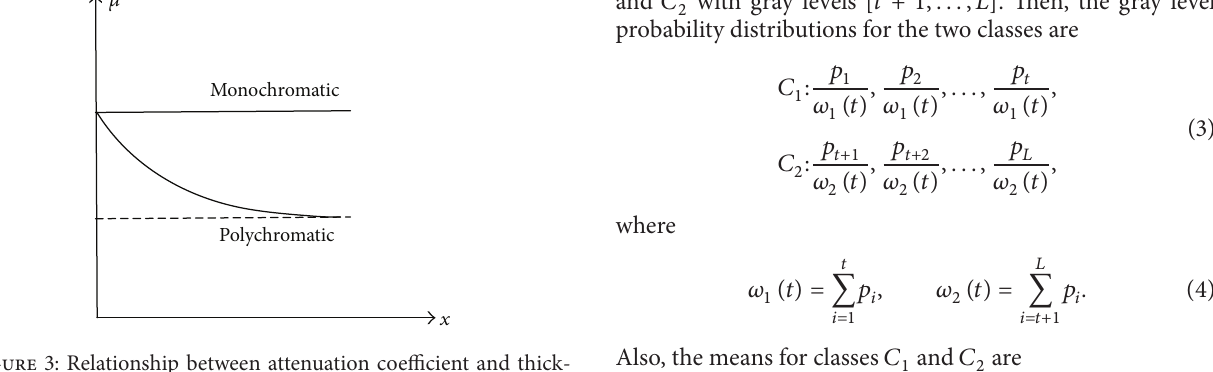
Figure 3: Relationship between attenuation coefficient and thick- ness of the